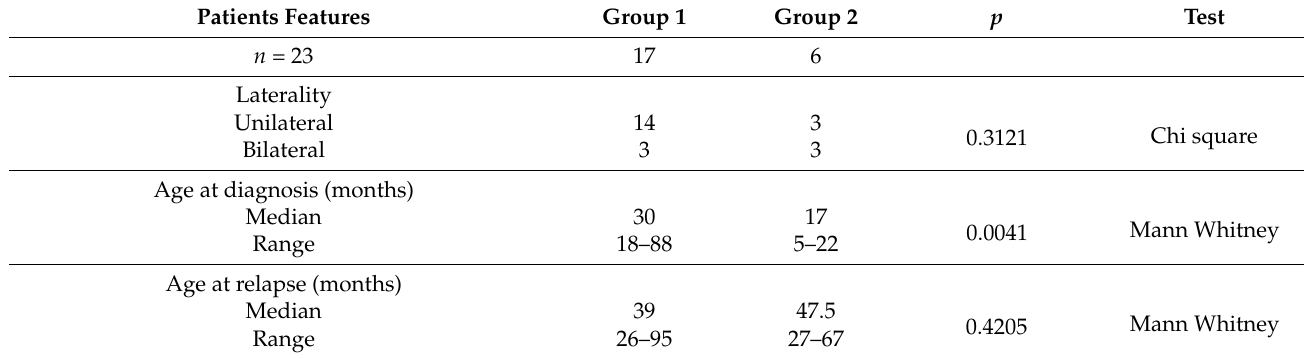
Table 1. Clinical and histopathological features of